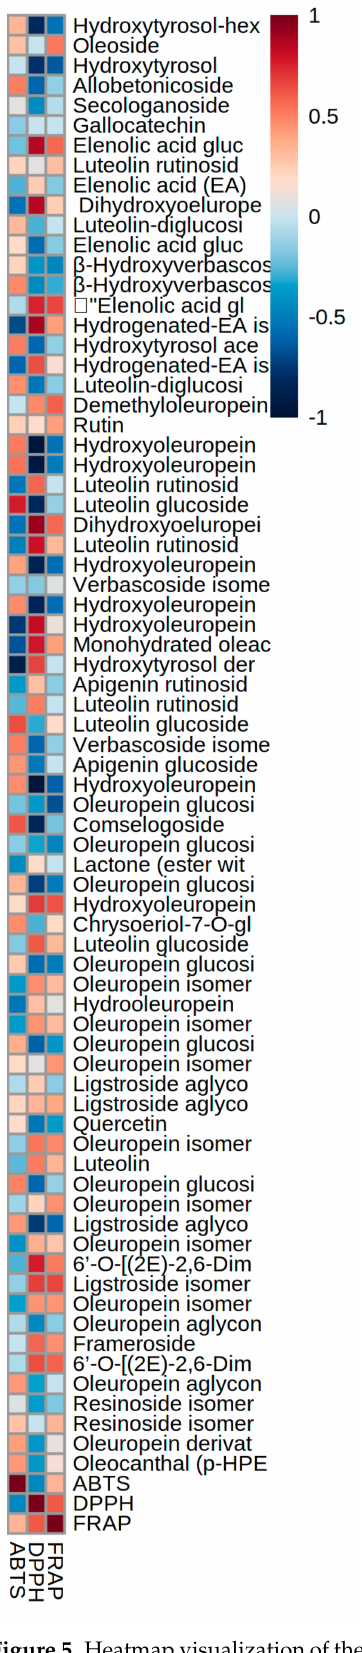
Figure 5. Heatmap visualization of the correlations between phenolic compounds and the antioxidant activity evaluated by ABTS, DPPH and